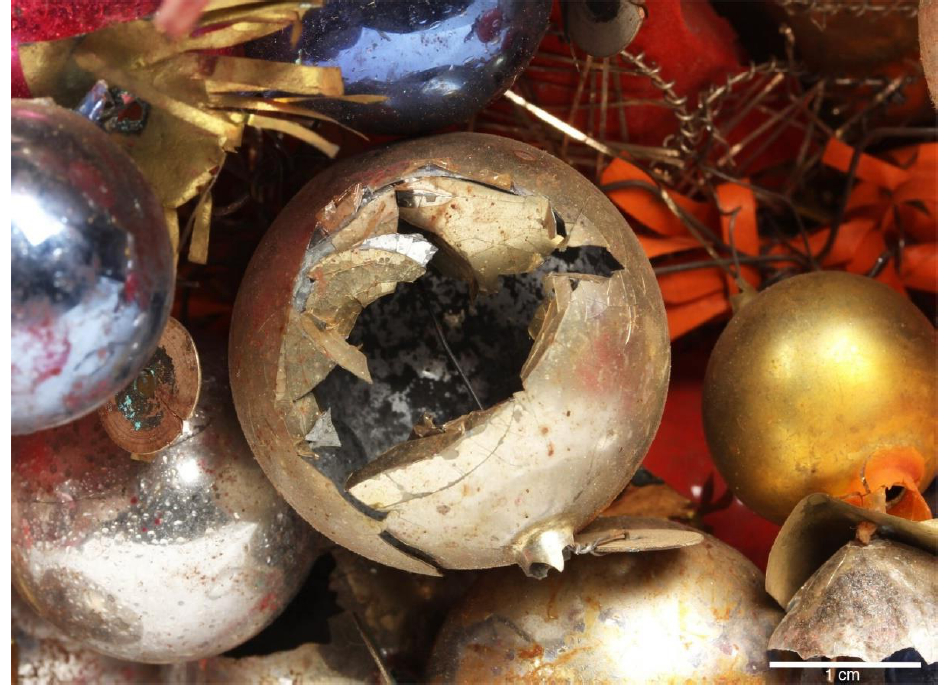
Figure 2. Broken lead coated glass sphere from a bridal crown) (Photo: Stephanie Wümmers)